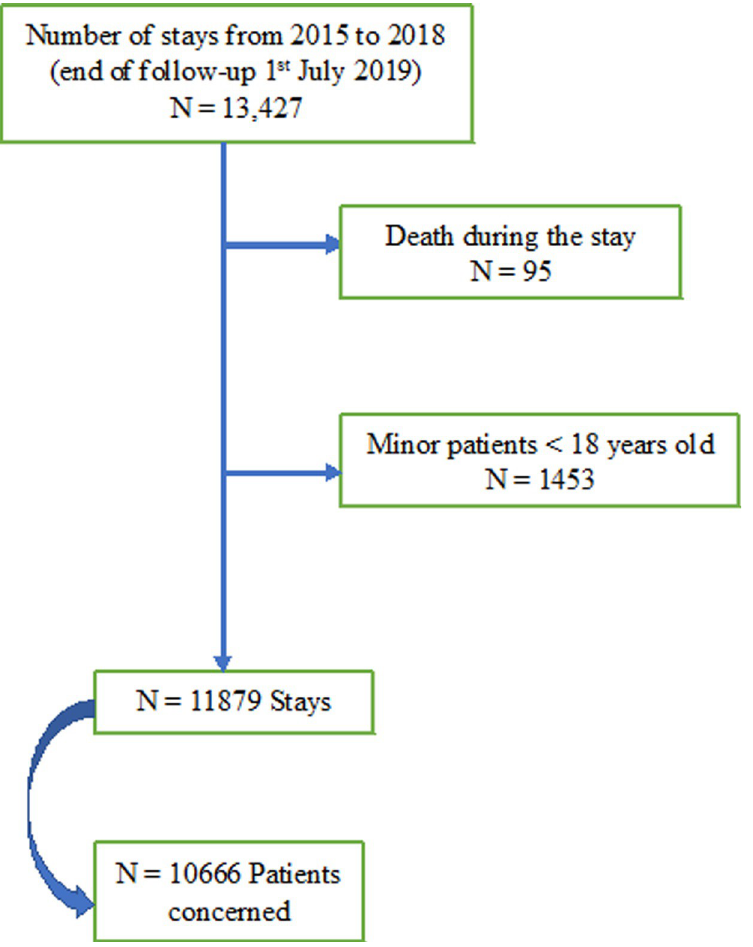
Fig 1. Flow chart for patient selection in the